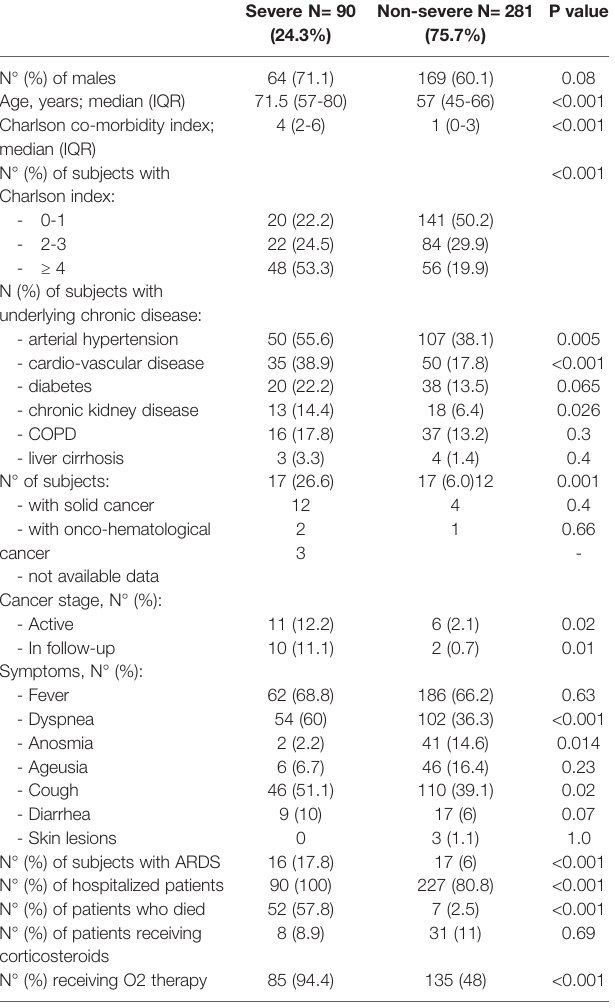
TABLE 3 | Comparison of patients with severe and non-severe clinical presentation of COVID-19.